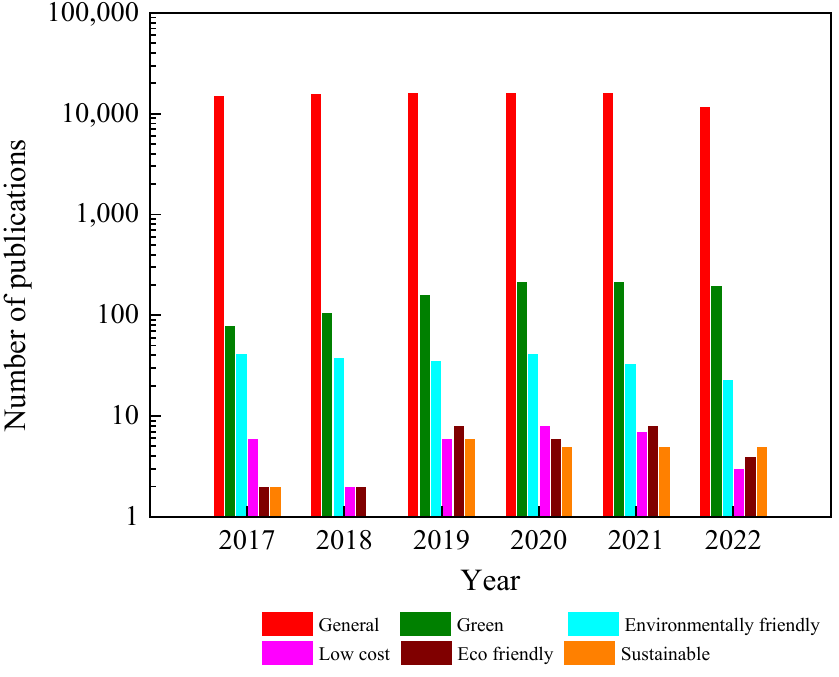
Figure 3. Synthesis of TiO 2 by growth methods in the last five years. Resource : Web of Science.